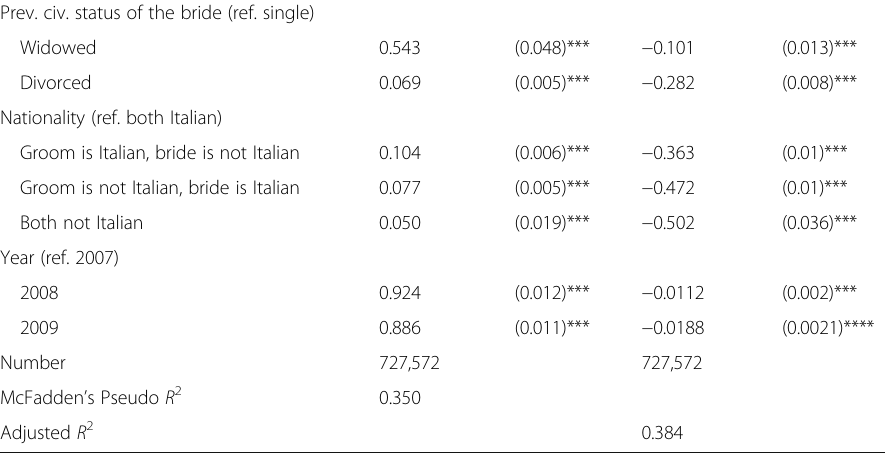
Table 4 Socio-demographic characteristics associated with the choice of marrying with the religious rite: results from a multivariate logistic regression. Italy, 2007 – 2009 (Continued) Prev. civ. status of the bride (ref.